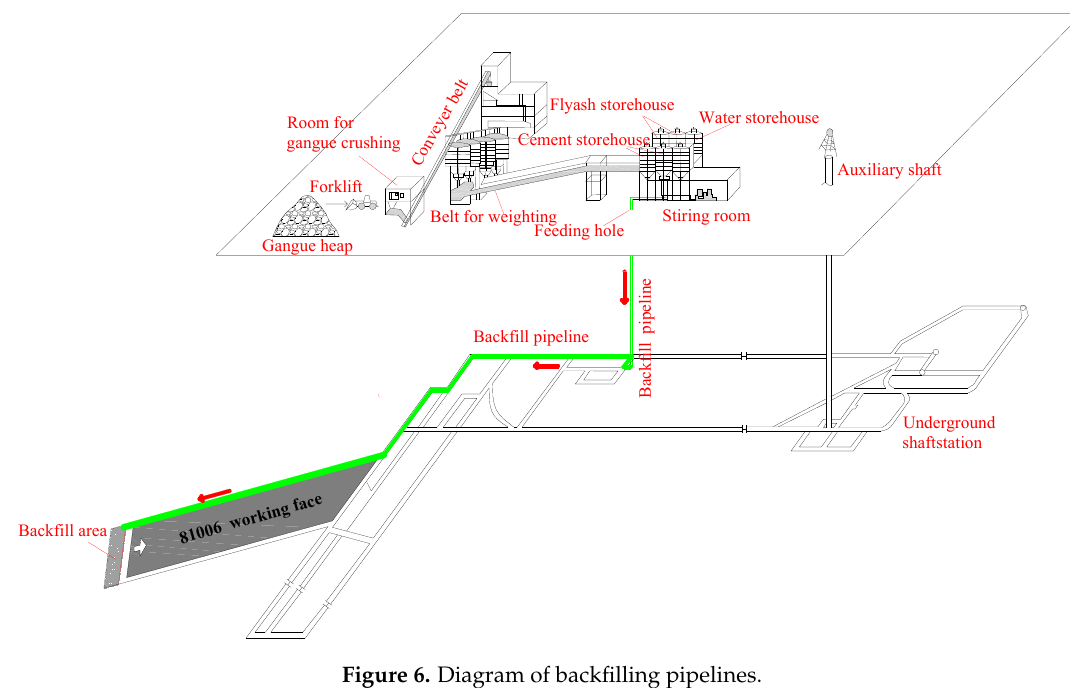
Figure 6. Diagram of backfilling pipelines.